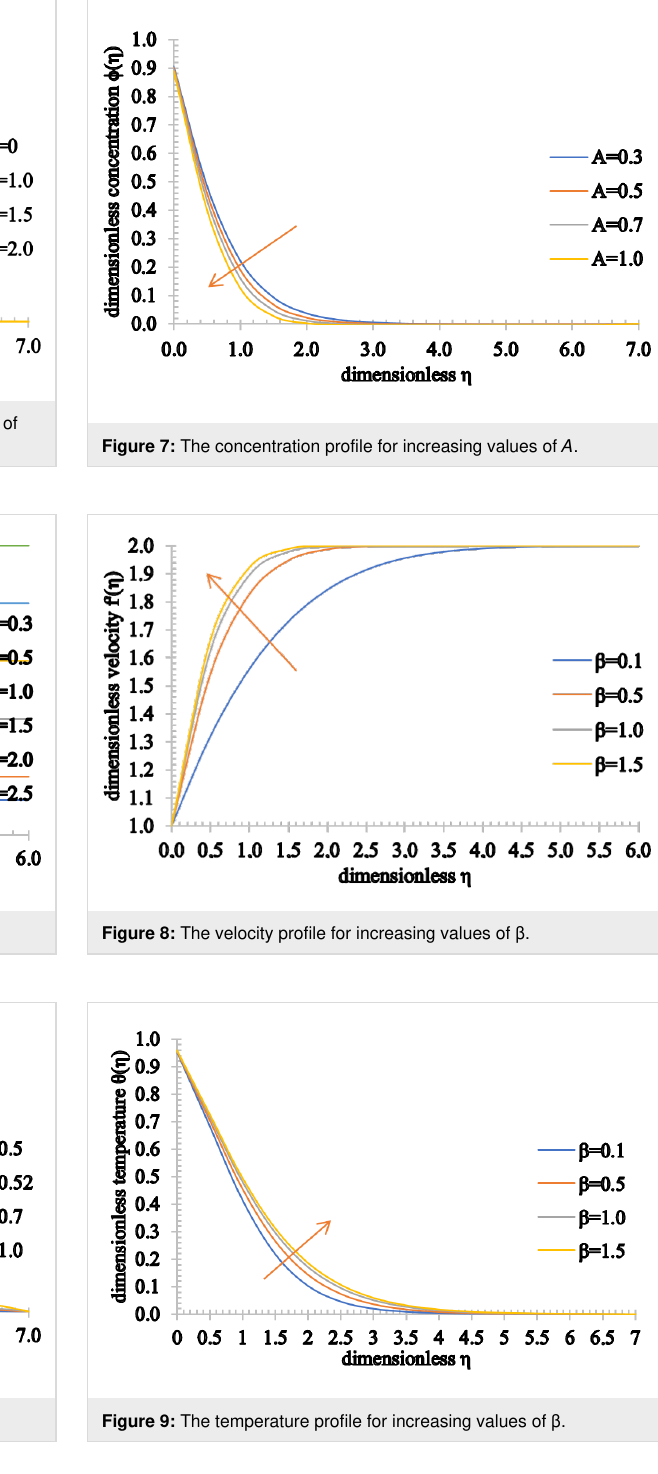
concentration boundary layer thickness increase for higher values of